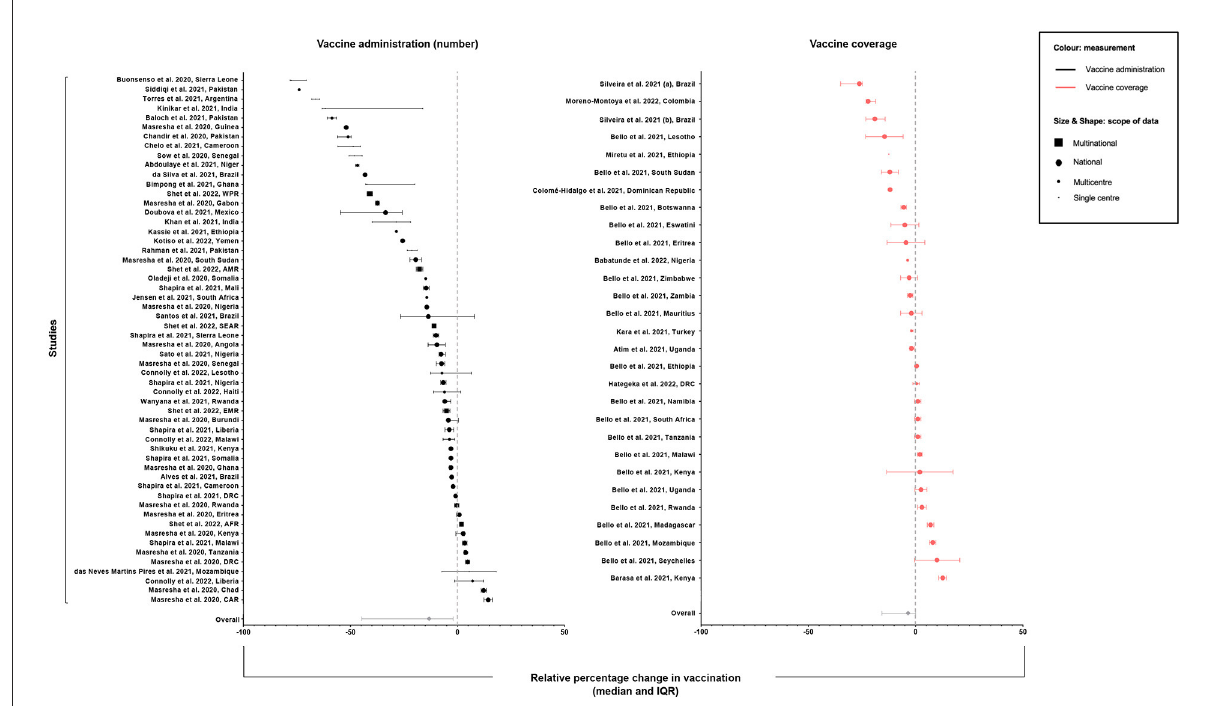
FIGURE3 Median relative percentage change ( ± IQR) in vaccination coverage or number of vaccines administered per study and overall across all